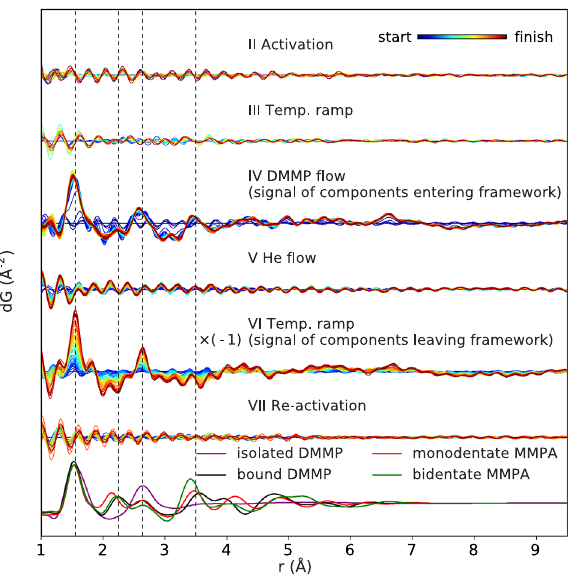
Fig. 6 Difference PDFs for each experimental stage. The dPDFs are shown for each experimental step, showing the differential change in pair distance distribution with respect to start of a given step, and with each step offset for comparison. For step VI, the dPDFs are fl ipped upside-down to show the signal of components leaving the framework during heating. The simulated PDF for an isolated molecule of DMMP and the dPDFs of DMMP and MMPA binding states are plotted for